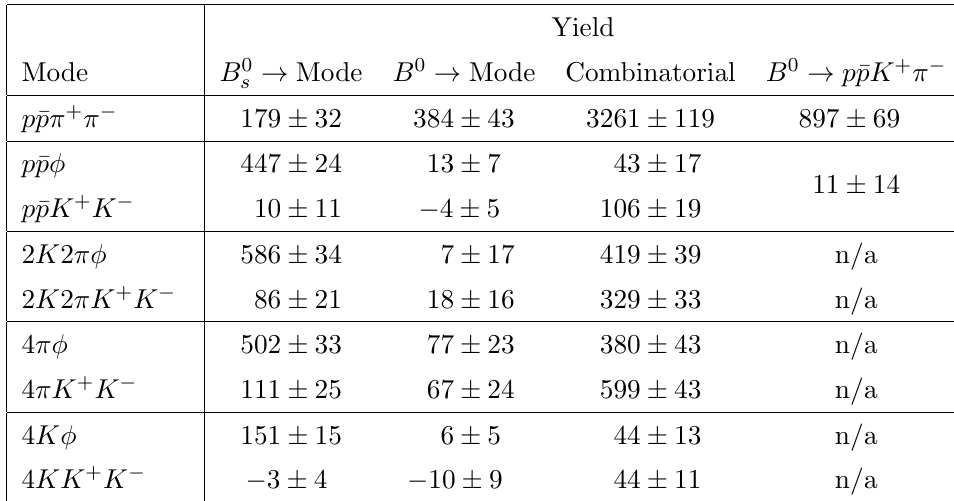
Table 2 . Yields of the di(cid:11)erent (cid:12)nal states as obtained from the (cid:12)t to the p (cid:22) p(cid:25) + (cid:25) (cid:0) invariant- mass distribution and from the 2D (cid:12)ts in the p (cid:22) p (4 h ) K + K (cid:0) (cid:2) K + K (cid:0) invariant-mass planes. Only statistical uncertainties are reported. The abbreviation \n/a" stands for \not applicable".